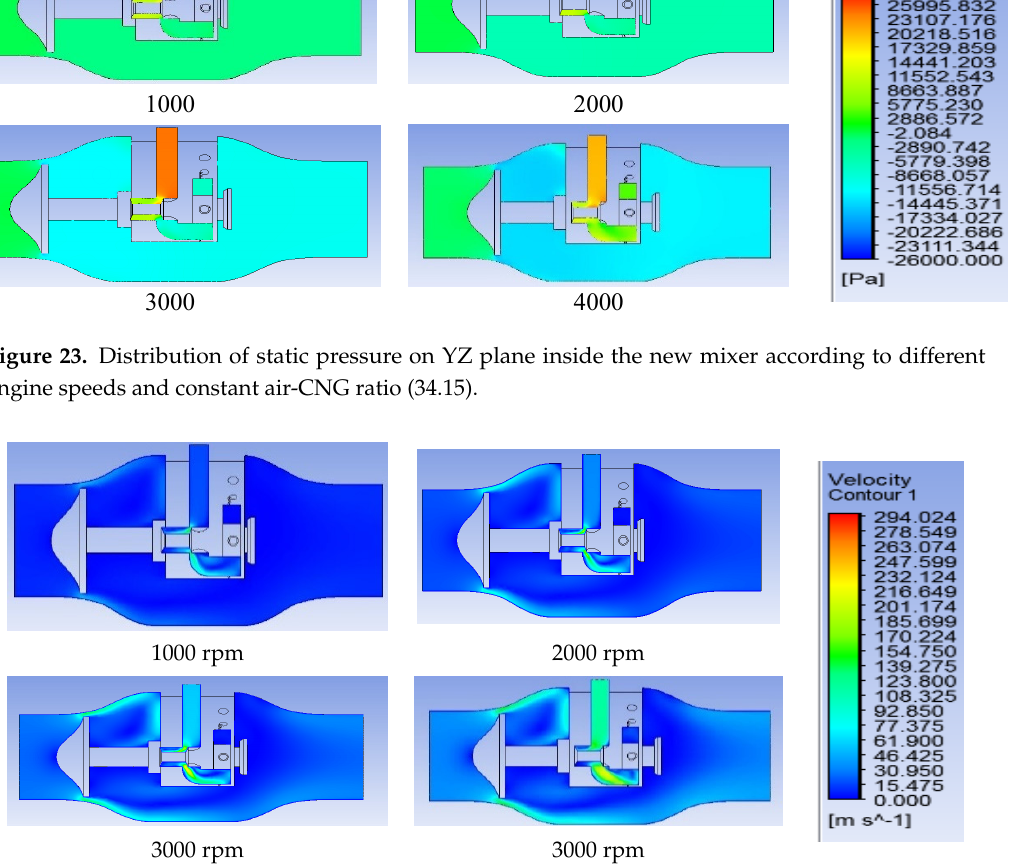
Figure 23. Distribution of static pressure on YZ plane inside the new mixer according to different engine speeds and constant air-CNG ratio (34.15).